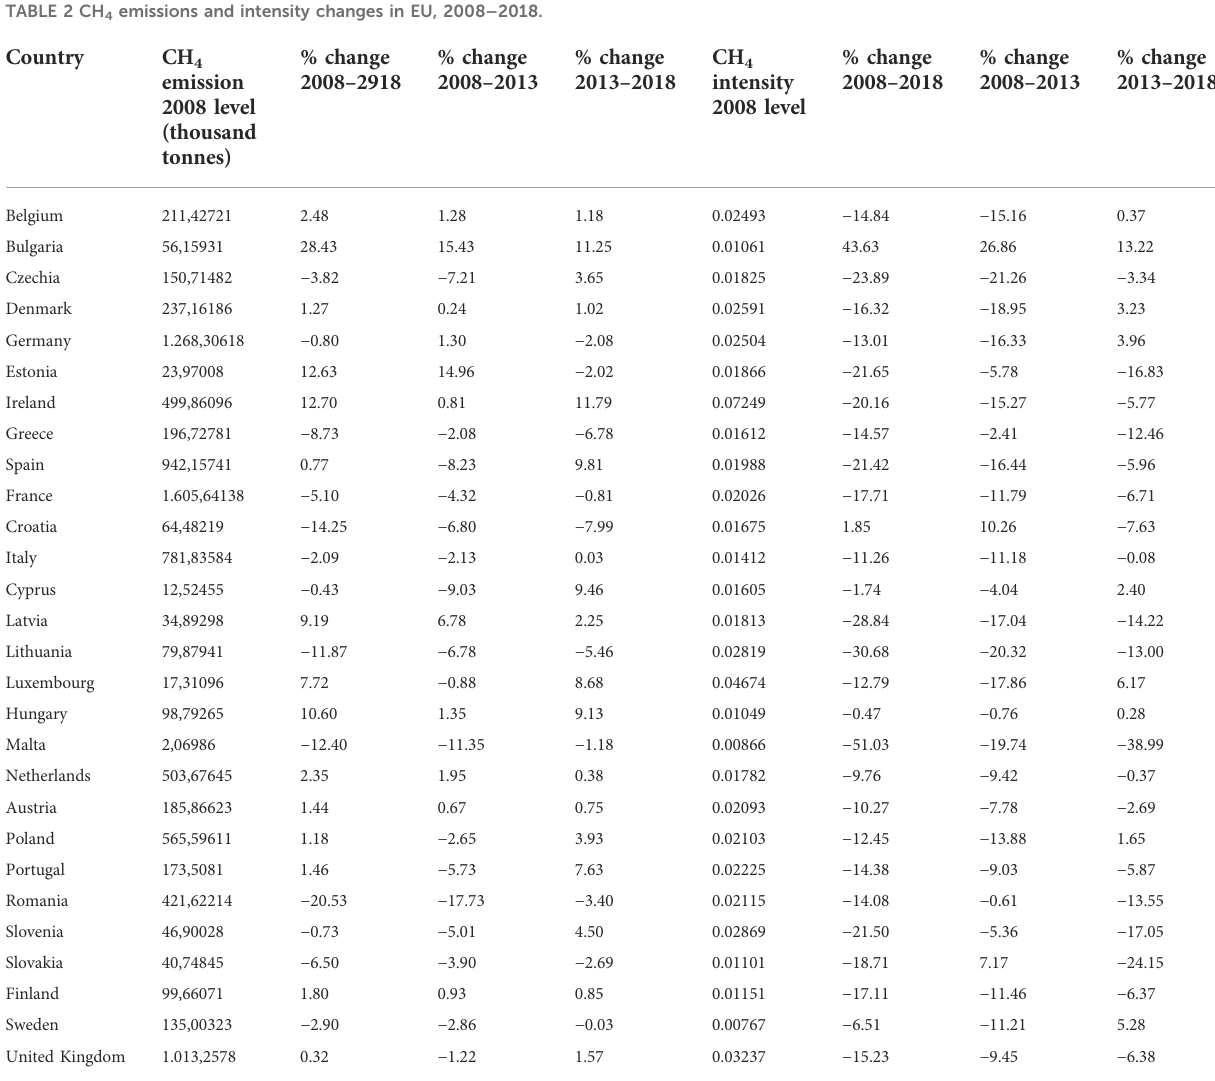
TABLE 2 CH 4 emissions and intensity changes in EU, 2008 –